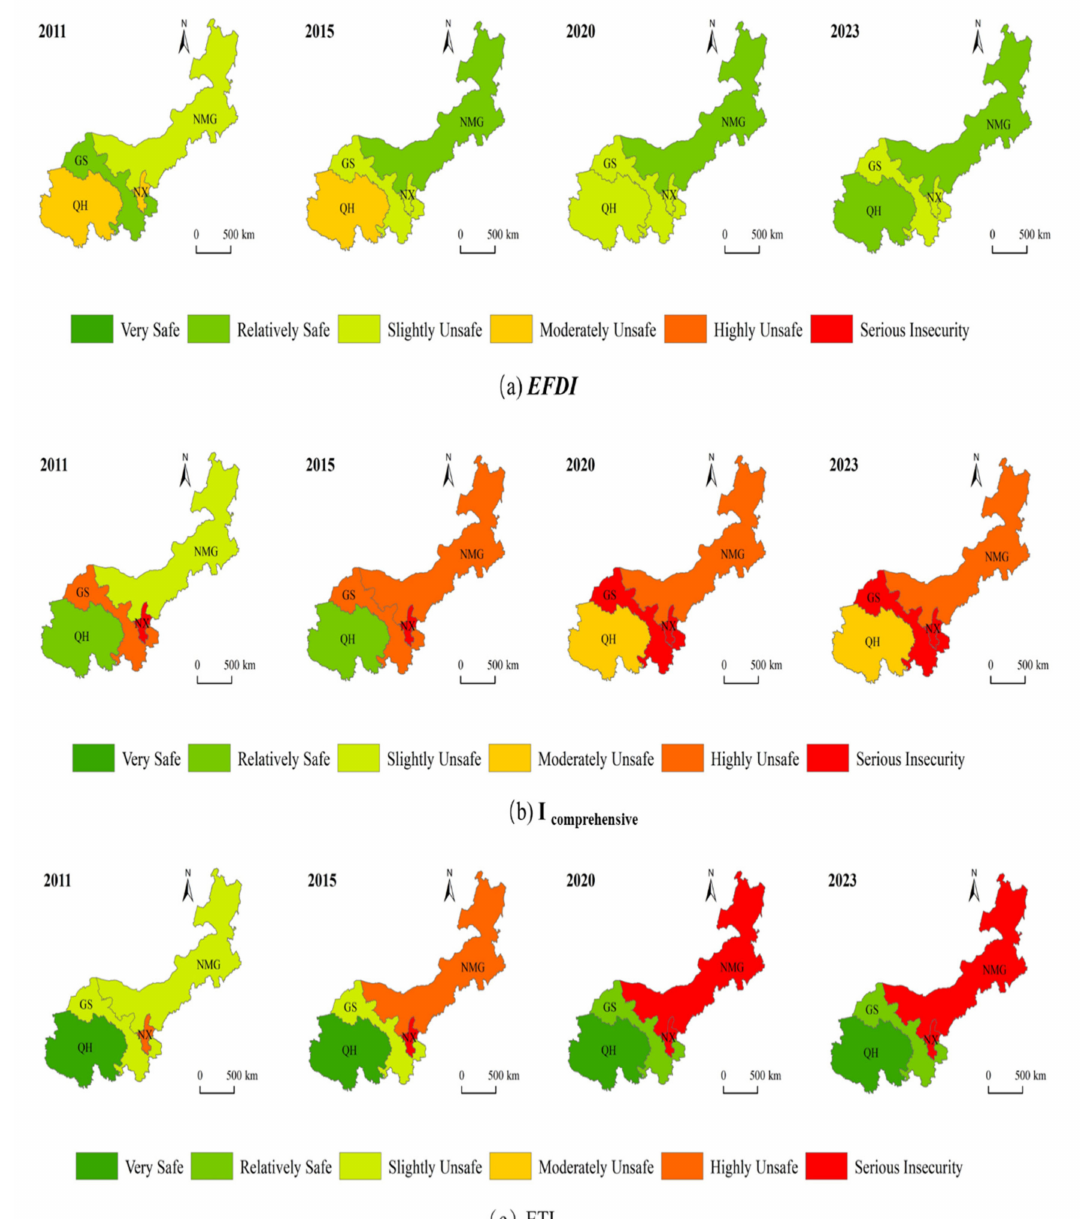
Figure 9. Spatial distribution of ecological security assessment indexes of provinces and regions in the upper reaches of the Yellow River from 2011 to